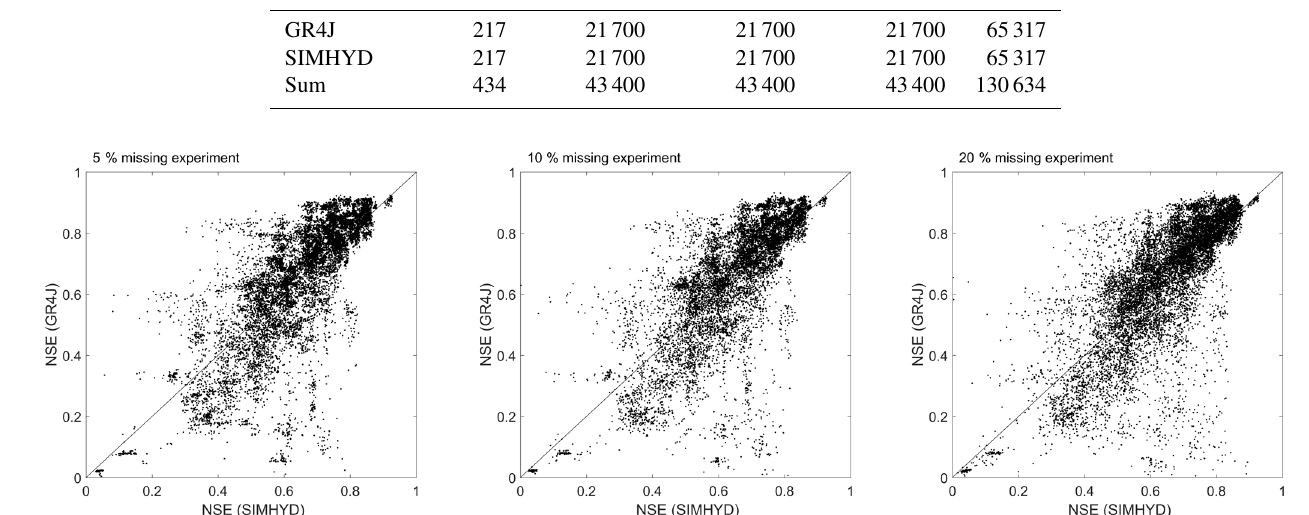
Figure 5. Comparisons between calibrated GR4J and calibrated SIMHYD for 44 catchments of the 5% missing data experiment, 39 catch- ments of the 10% missing data experiment, and 22 catchments of the 20% missing data experiment. In each catchment, there were 100 replicates carried